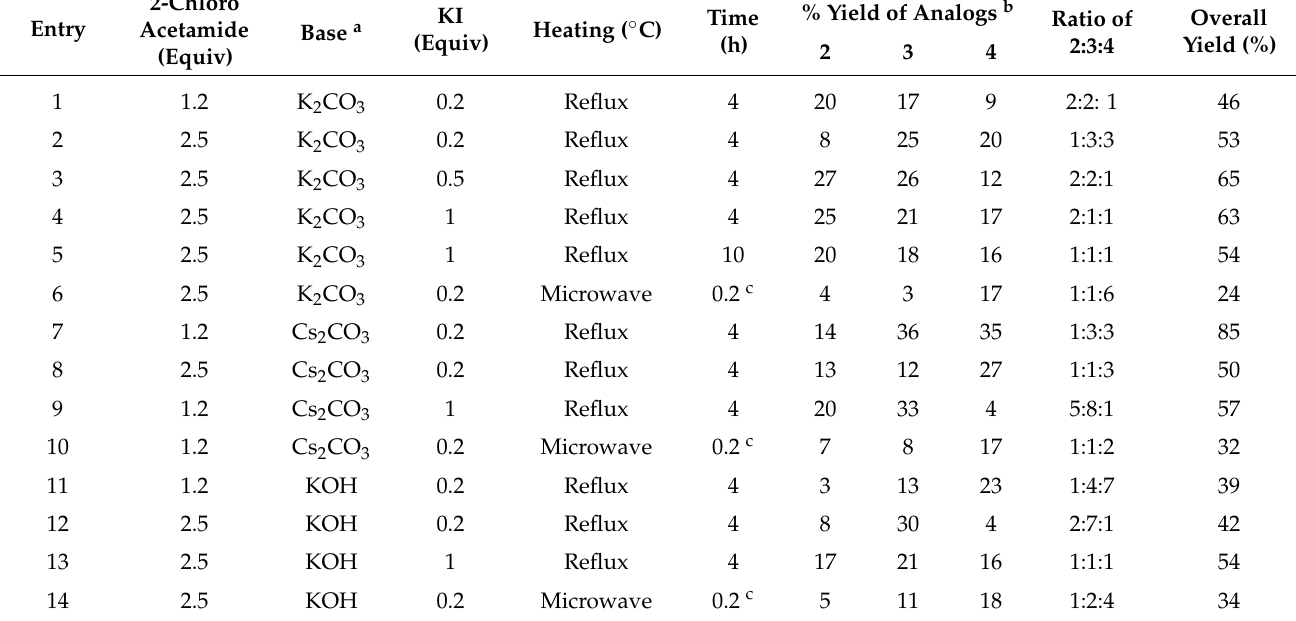
Table 1. Optimization of the Smiles rearrangement of α -mangostin ( 1